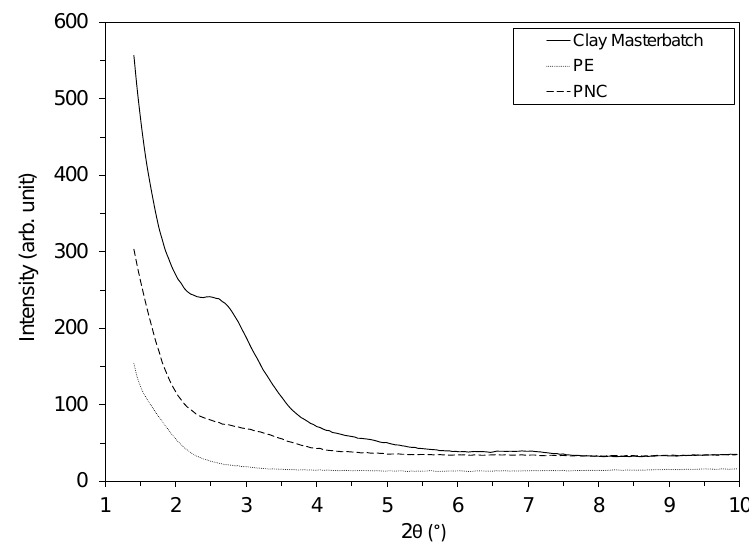
Figure 2. X-ray diffraction patterns of PE, PNC and Clay Masterbatch.